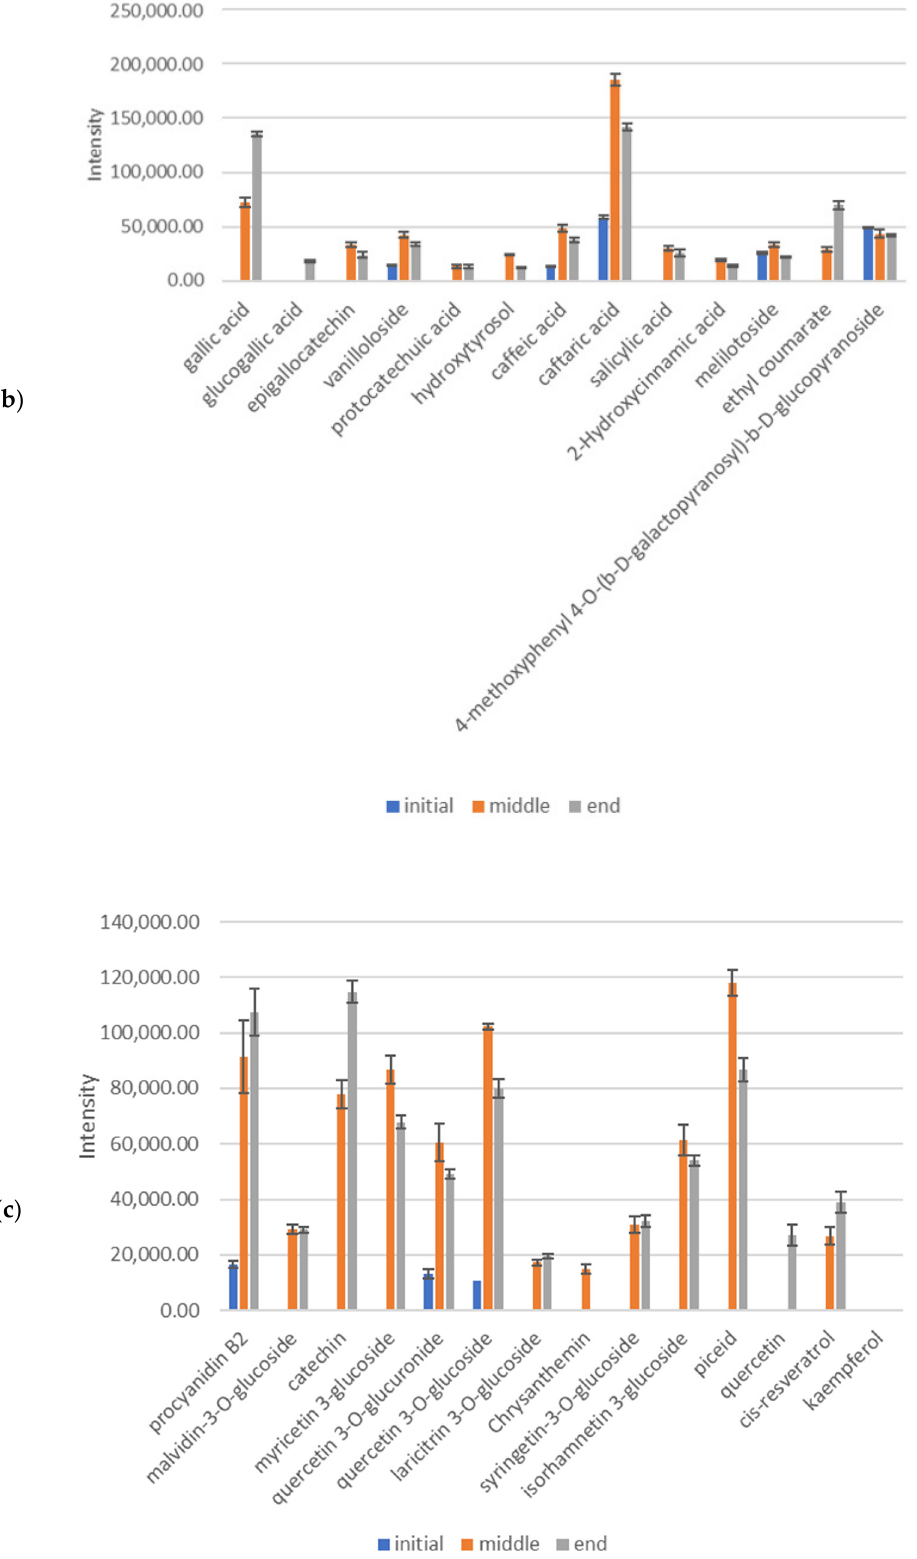
Figure 3. Evolution of the compounds present in the must during the fermentation process for the grapes from terroir 2: ( a ) glucose and organic acids; ( b ) phenolic acids and their derivatives; ( c ) phenolic compounds. The compound appearing as 4-methoxyphenyl 4-O-(b-D- corresponds to 4-methoxyphenyl